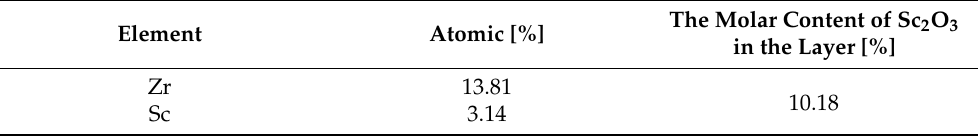
Table 3. Average chemical composition determined by EDS analysis and calculated molar content of Sc 2 O 3 in the layer (Figure 3). The synthesis temperature: 650 ◦ C. The molar content of Sc(tmhd) 3 in the gas mixture: 14%. Total gas pressure: 10 5